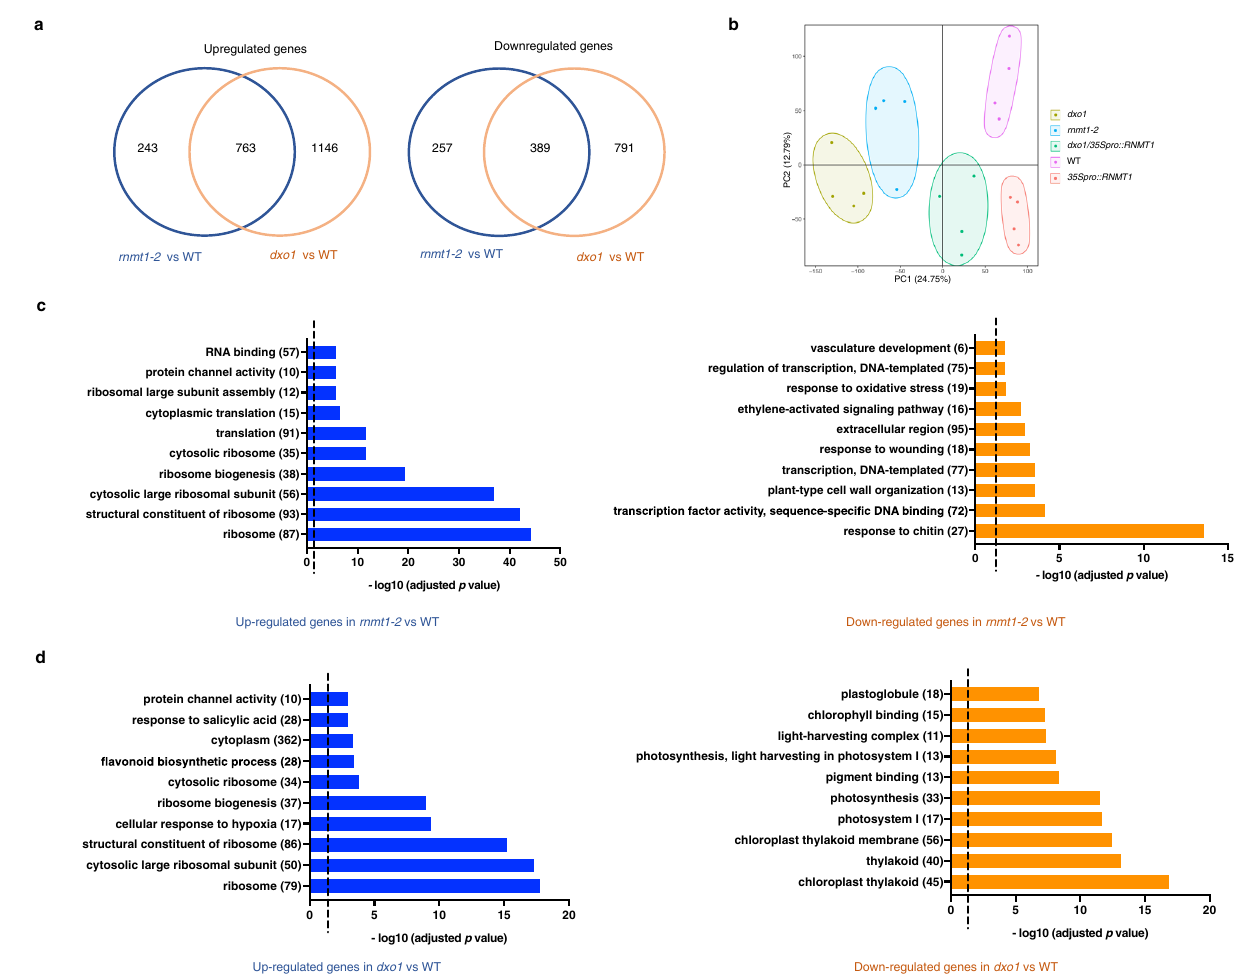
Fig. 6 | Differentially expressed genes caused by the rnmt1-2 and dxo1 muta- tions. a Venn diagrams show the number of up- and downregulated DEGs (in relationtoexpressioninWT)thatoverlapbetweenthe rnmt1-2 and dxo1 genotypes. b PCA of the transcriptomes from WT, rnmt1-2, dxo1, 35Spro:RNMT1 and dxo1/